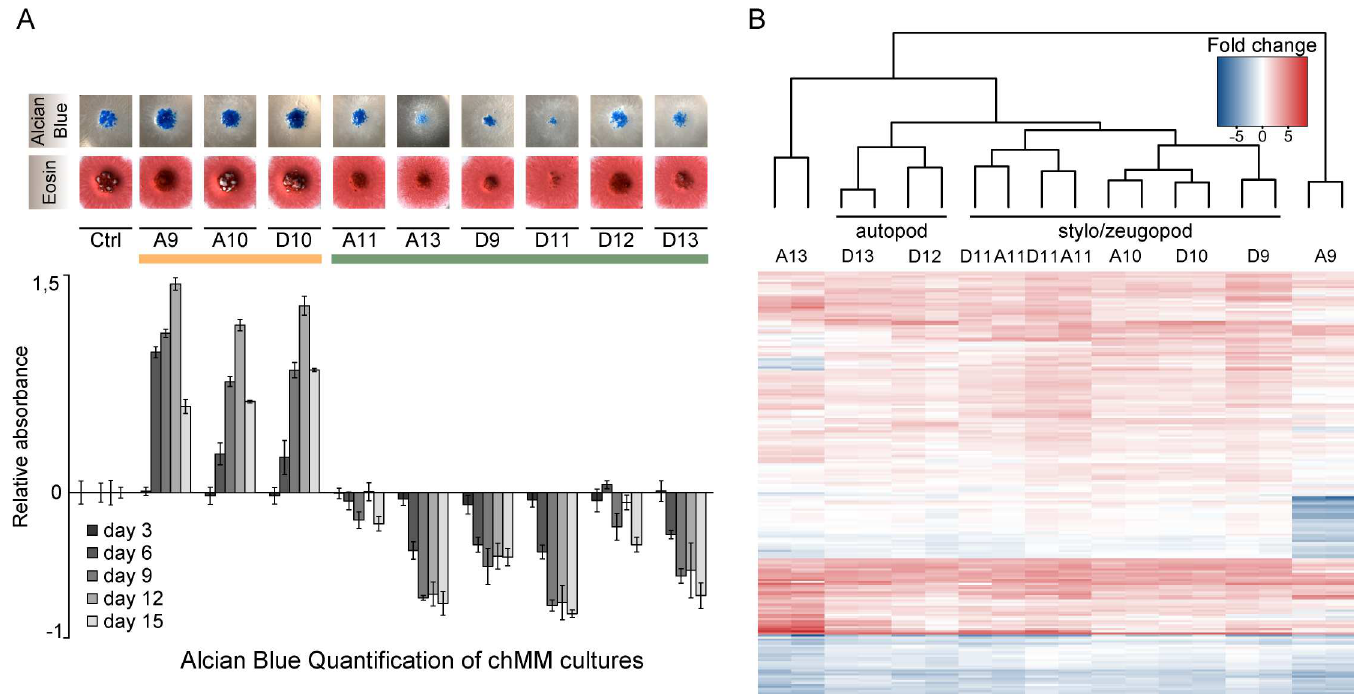
Fig 1. Viral expression of HOX-TFs in chicken micromassculture (chMM) modifies chondrogenic cell differentiation. (A) IndividualHOX-TF expressingchMM cultures stained with Alcian blue (top) and Eosin (bottom). Alcian Blue stainingof four biologicalreplicates was quantifiedand comparedto mock-infectedchMM. Error bars indicate standarddeviationfrom four replicates. (B) Hierarchical clusteringof differentiallyregulatedgenesin the nine HOX-TF expressingcultures (all RNA-seq shown in replicates). The top 50 differentially regulatedgenes from each sample were selected(Criteria: p-Val (cid:20) 10e-5, base mean (cid:21) 30,fold change (cid:21) 2)and for each replicate, the log2-transformed fold changesrelativeto mock-infected cultures of these 205 genes were subjectedto hierarchical